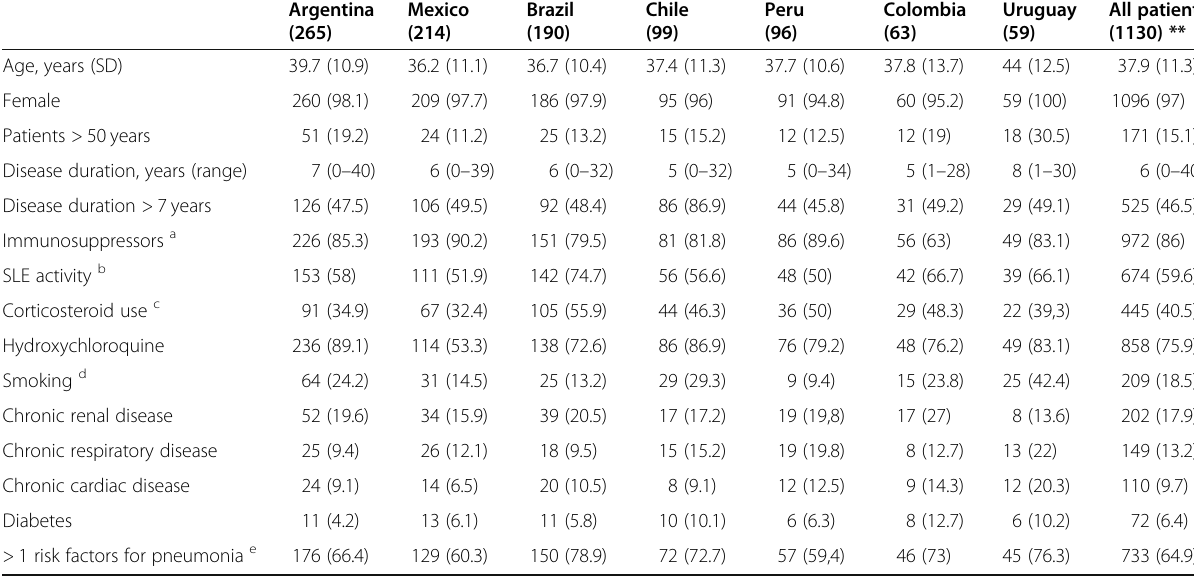
Table 1 Demographics, risk factors for pneumonia, and SLE-specific data of Latin American